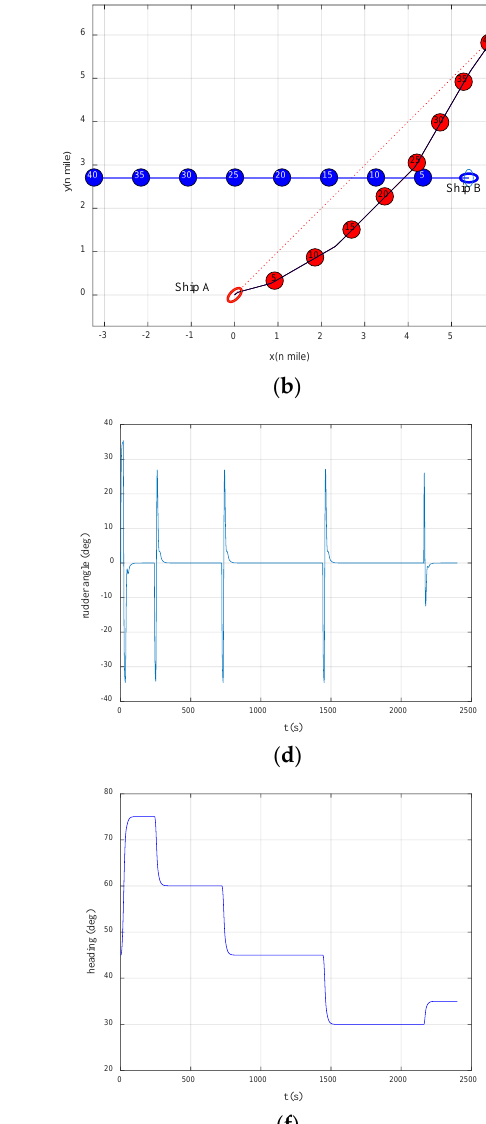
Figure 11. Simulation results for a small crossing angle situation. ( a ) Initial traffic configuration; ( b ) optimal trajectory; ( c ) relative distance; ( d ) rudder angle of ship A; ( e ) velocity of ship A; and ( f ) heading of ship A.